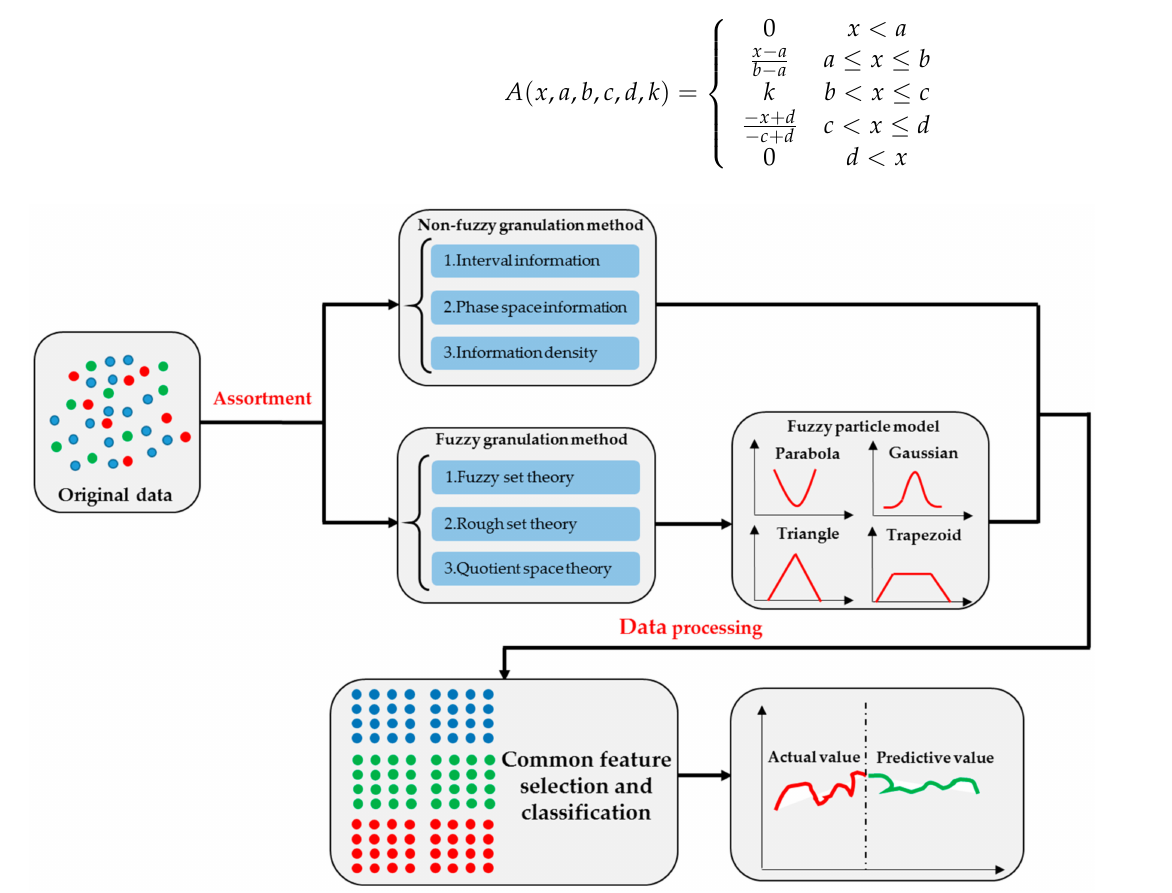
Figure 2. Schematic diagram of information